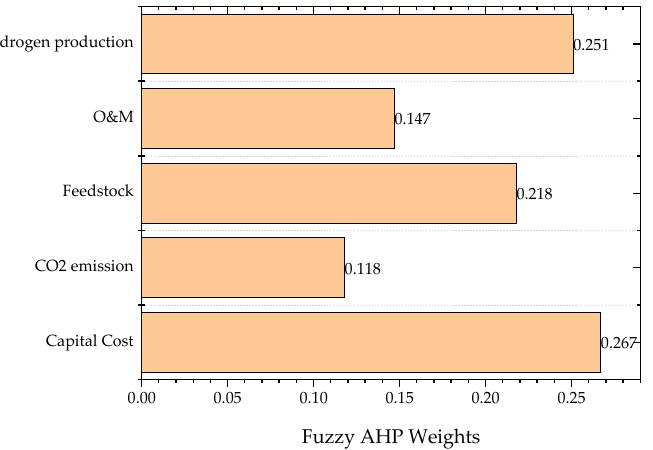
Figure 3. Initial weights of criteria.